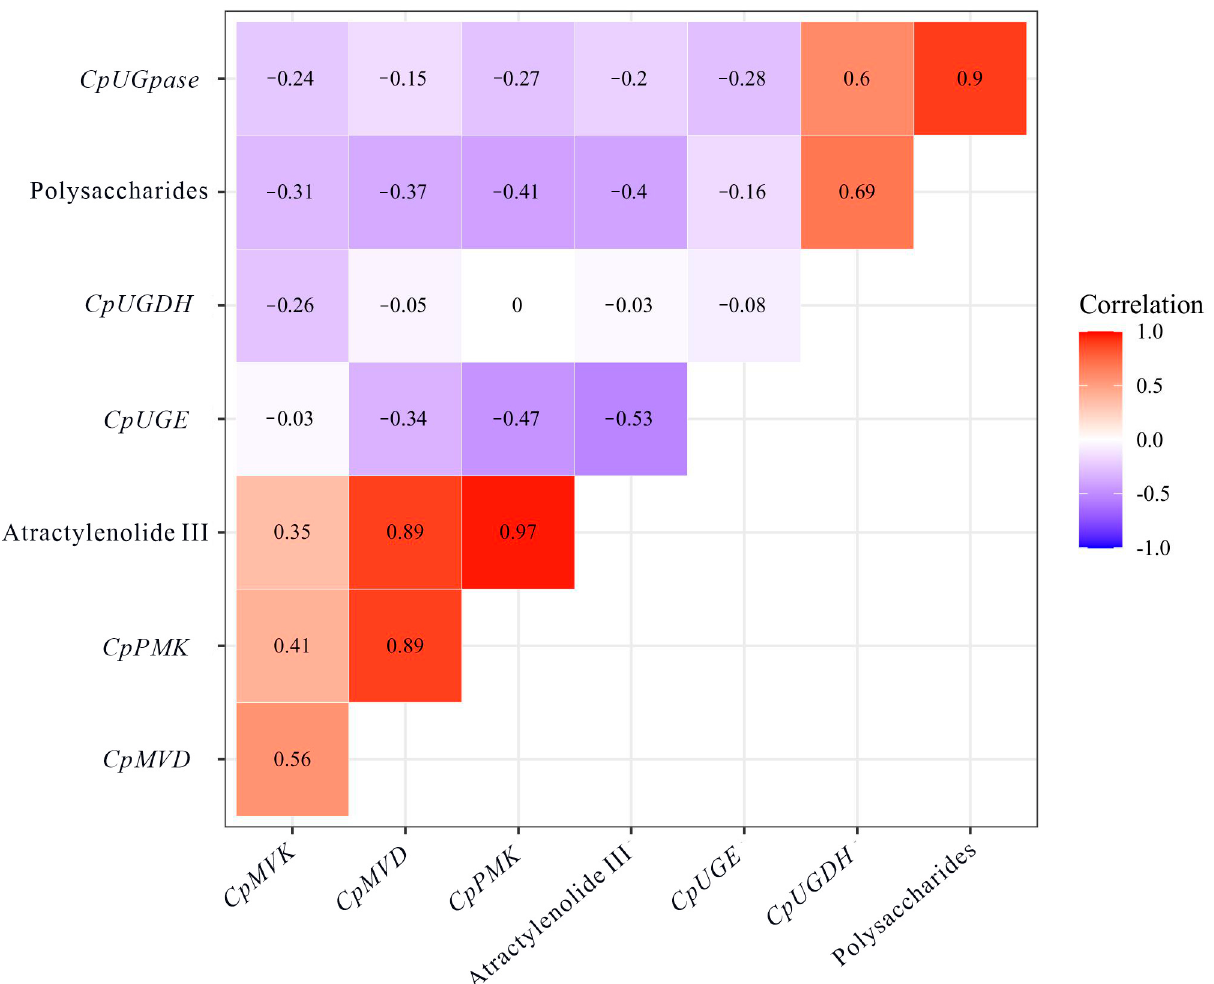
Figure 6. Pearson’s correlation matrix for multiple genes, atractylenolide III, and Codonopsis pilosula polysaccharides. The scale on the right side shows color codes with corresponding r values. Different letters above the bars indicate a significant difference ( p < 0.05) by one-way ANOVA with Tukey’s post-hoc test.